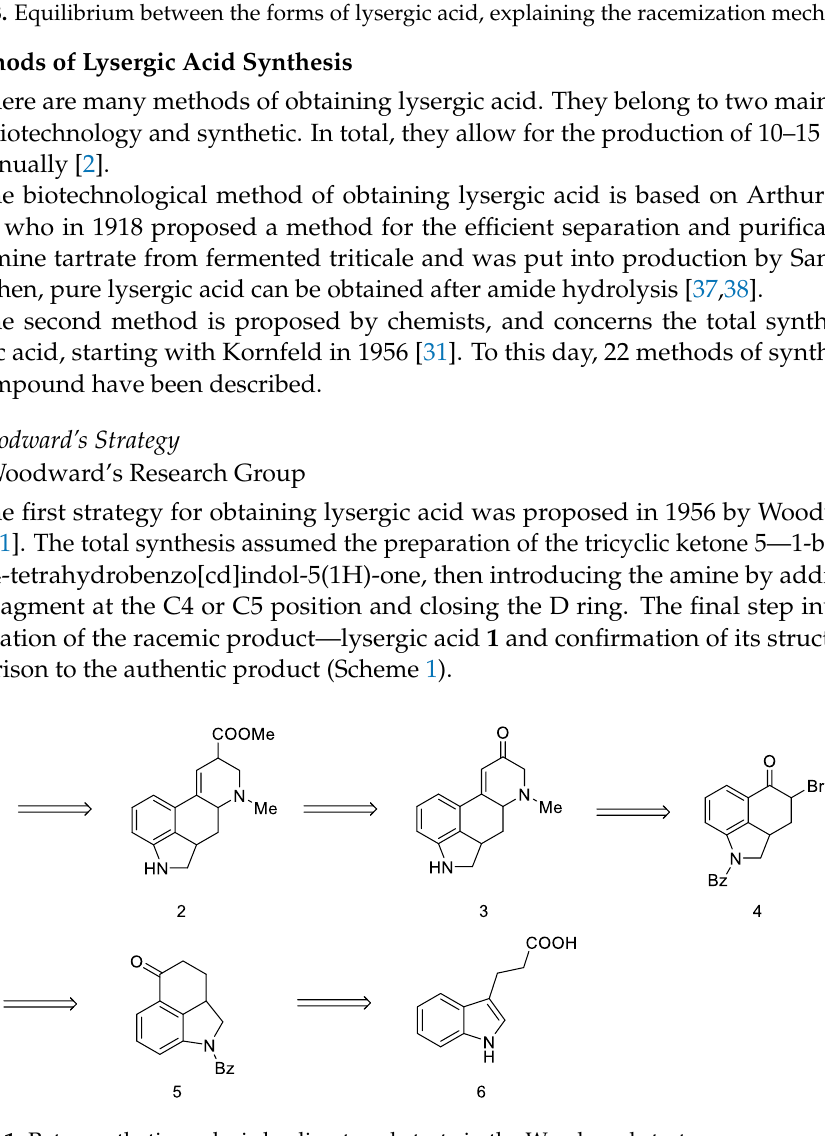
Figure 9. Indole scaffold (red) in the lysergic acid molecule. The first step was to functionalize and reduce the starting material to the protected derivative of N-Benzoyl-3- (β -carboxyethyl)-dihydroindole 7 [40]. N-Benzoyl-3- (β -carbox- yethyl)-dihydroindole was treated with thionyl chloride to the corresponding acid chlo- ride and then converted into ketone 5 by the Friedel – Crafts reaction. Ketone 5 can be easily hydrolyzed with hydrochloric acid to the free base as well as dehydrogenated over carbon over palladium to the known 3,4-dihydro-benzo[cd]indol-5-one 8, known in the literature as the Uhle’s ketone (Scheme 2) [41]. Scheme 2. Obtaining U hle’s ketone 8 . Very first attempts to obtain lysergic acid . Using the obtained ketone 5 , attempts were made to introduce nitrogen into the C4 position (Figure 10).